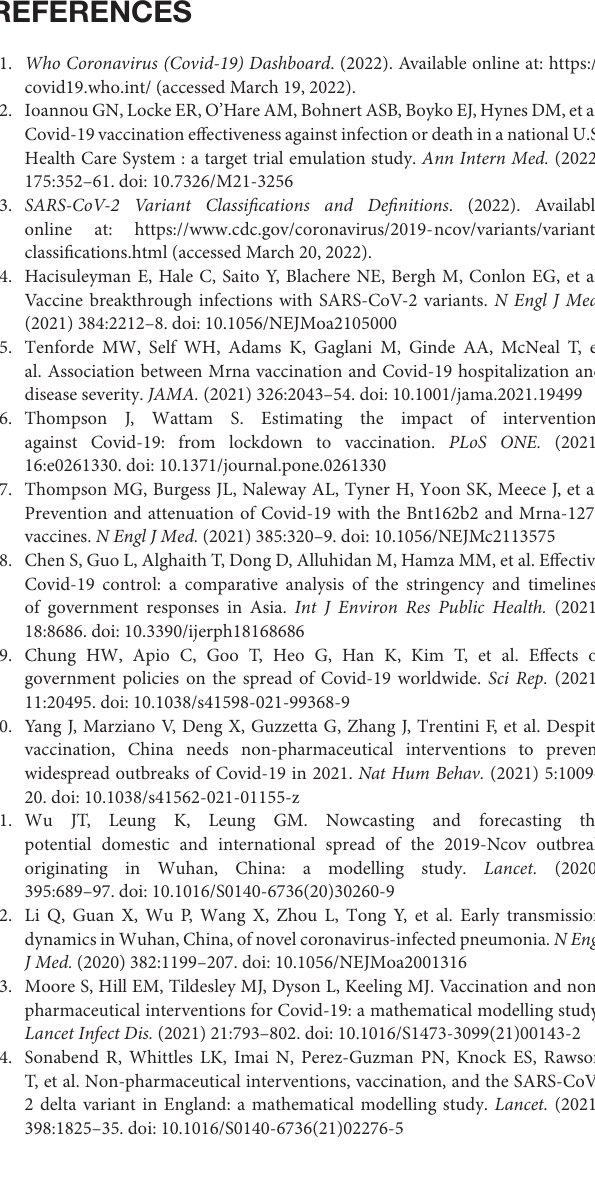
number denotes the median, and error bars denote quantiles 0.025 and 0.975. Supplementary Figure 2 | Number of countries of short-term (a) and long-term (b) effects. Part (a) shows that proportions of countries being effective were higher in Europe and North America than that in Africa and Asia. Part (b) reveals that the proportions were higher in Europe as well. All countries showed significantly effective on vaccination by Equations (2) or (3). Supplementary Figure 3 | Human development index had strong positive correlations with the people vaccinated rate (a) and people fully vaccinated rate (b) . Supplementary Figure 4 | Relationship of human development index (HDI) and cumulative incidence rate among countries. The figure reveals that HDI had a positive correlation with cumulative incidence rate among countries. The number denotes the median, and error bars denote quantiles 0.025 and 0.975. ∗∗∗ means that the group had a significant difference from the other three